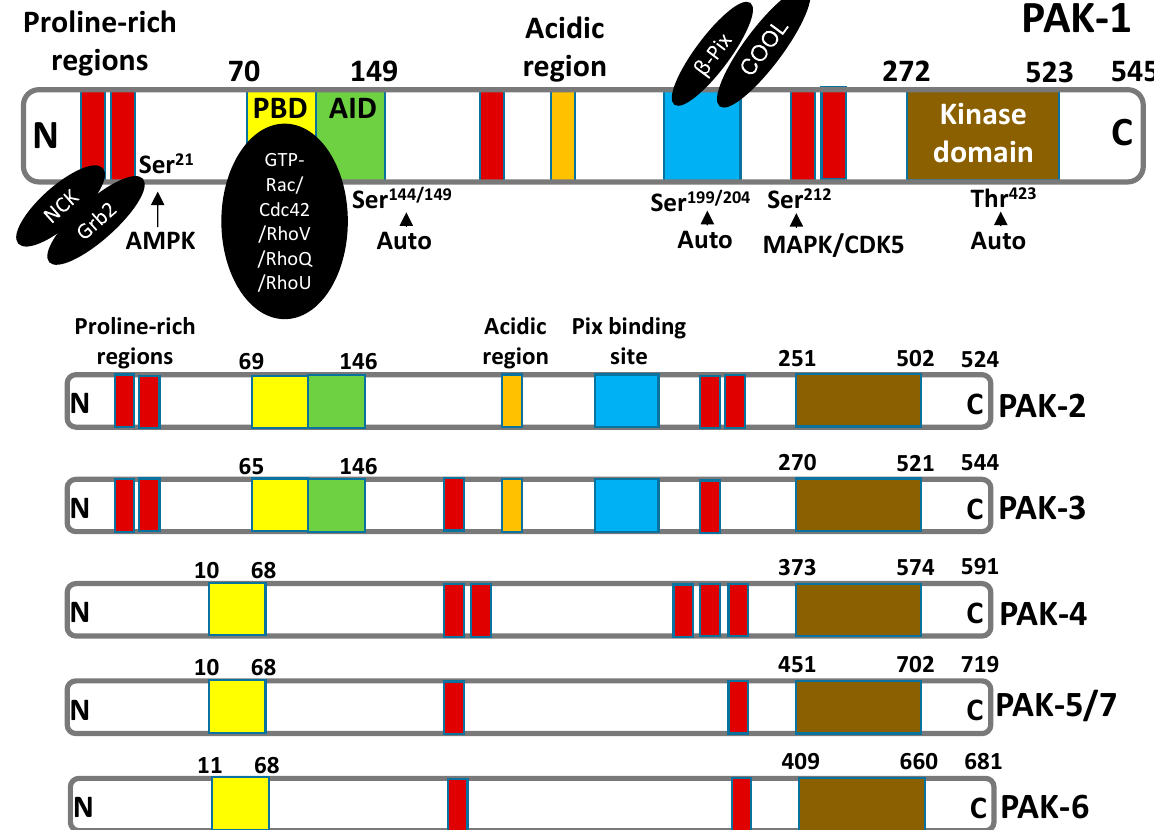
Figure 1. Schematic representation of the structure of human PAK isoforms. Group-I PAKs (PAK1-3) contain a conserved overlapping PBD/AID region. Interaction of small GTPases (GTP-bound Rac and cdc42) with the PBD domain releases group-I PAKs from auto-inhibition. Group-II PAKs (PAK4-6) do not contain AID, acidic and PIX-binding regions that are present in Group-I PAKs.